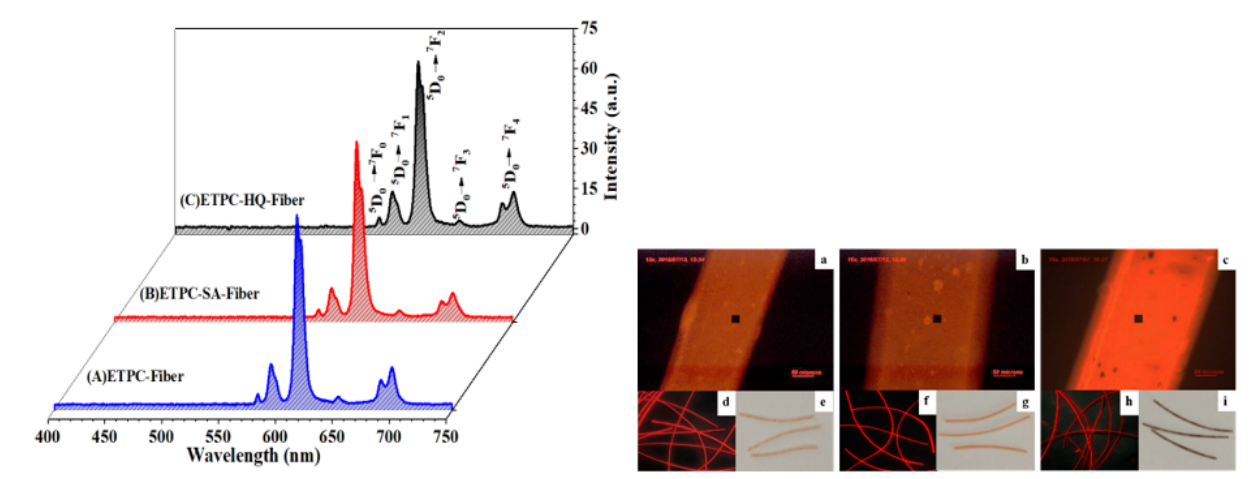
Figure 9. Luminescent properties of CLCCs in fluorescent fibers. (1) Emission spectra: (A) ETPC fiber, (B) ETPC-SA fiber, and (C) ETPC-HQ fiber u, (upon excitation at 365nm). (2) Photofluorogram: ( a ) ETPC fiber, ( b ) ETPC-SA fiber, and ( c ) ETPC-HQ fiber. (3) Contrast of fluorescent fibers under ultraviolet and under natural room light: ( d , e ) ETPC fiber, ( f , g ) ETPC-SA fiber, and ( h , i ) ETPC-HQ fiber.